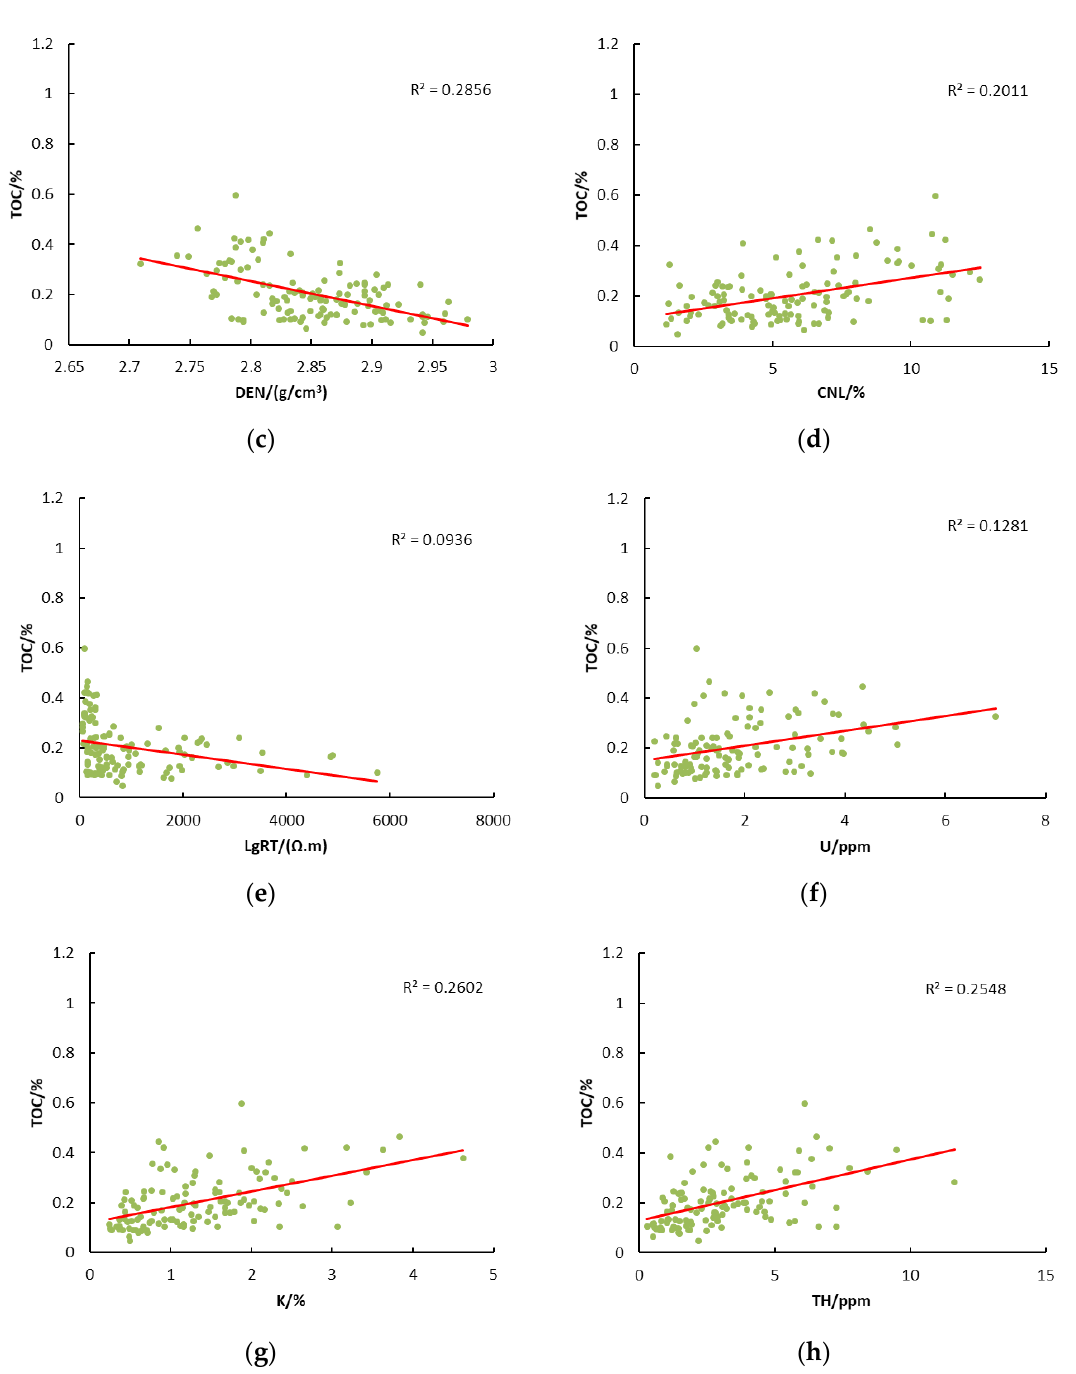
Figure 5. Correlation between TOC content and ( a ) natural gamma ray, ( b ) acoustic time difference, ( c ) organic matter density, ( d ) neutron porosity, ( e ) formation resistivity, ( f ) uranium, ( g ) kalium and ( h ) thorium.